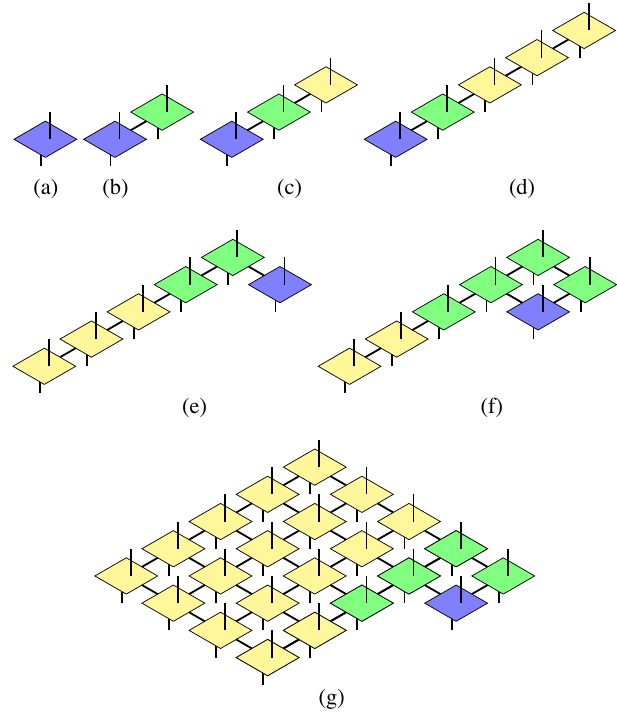
FIG. 7. Sequential creation of the tensor network that describes the maximum-entropy state [Eq. (F1)]. The outward-facing legs are the physical degrees of freedom, one representing the “ bra ” and the other representing the “ ket. ” The blue tensors are the newly introduced tensors, and the green tensors are the ones that are nontrivially affected by the local channel that creates the blue tensor. The yellow tensors remain unaffected. (a) First